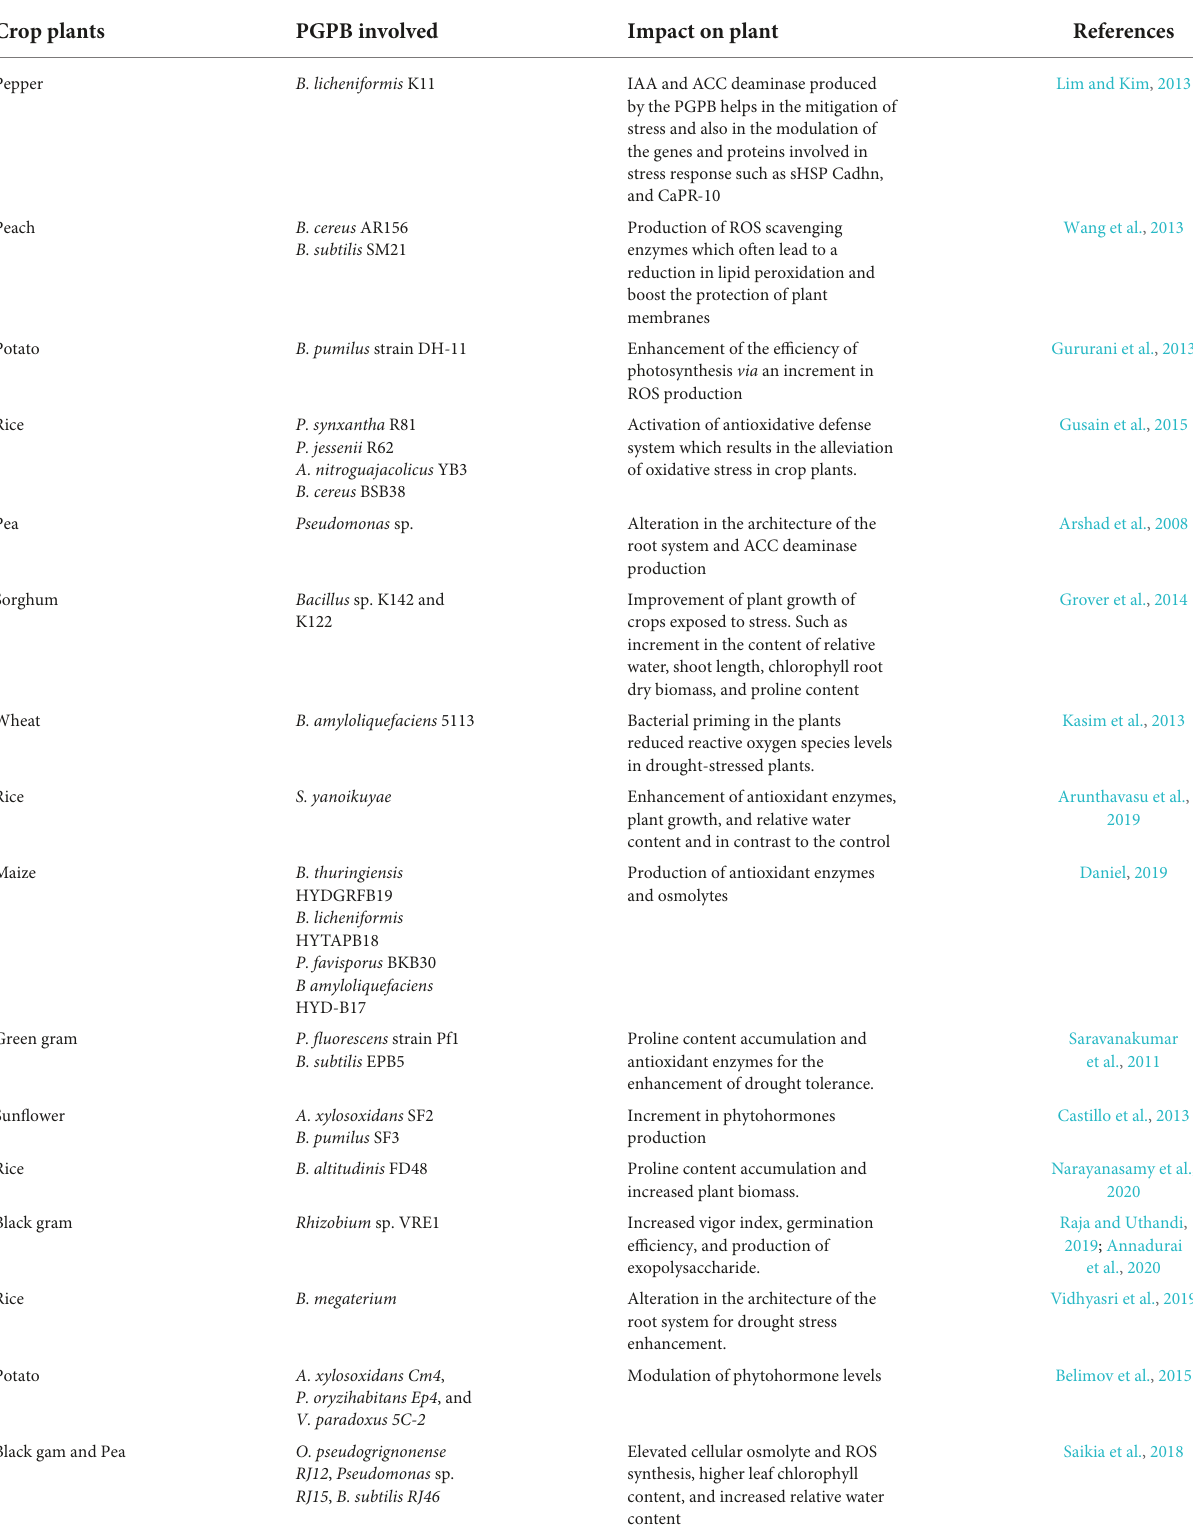
TABLE 1 Impact of PGPB in the enhancement of drought tolerance in crop plants. Crop